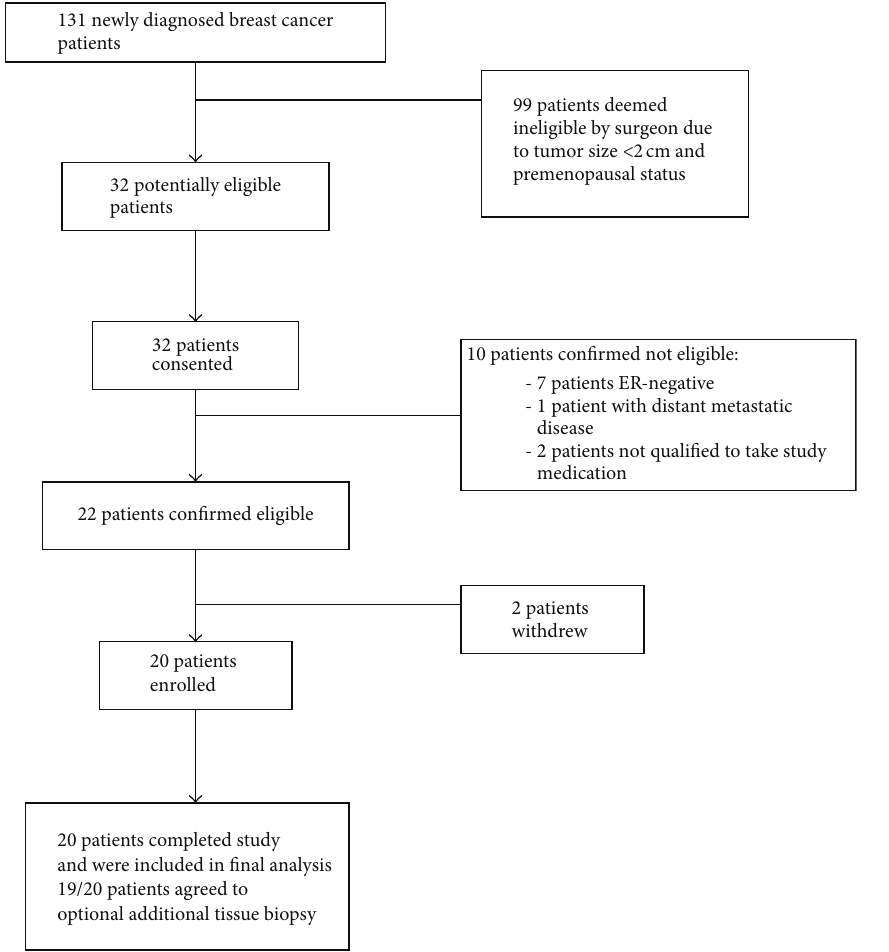
Figure 2: Patient